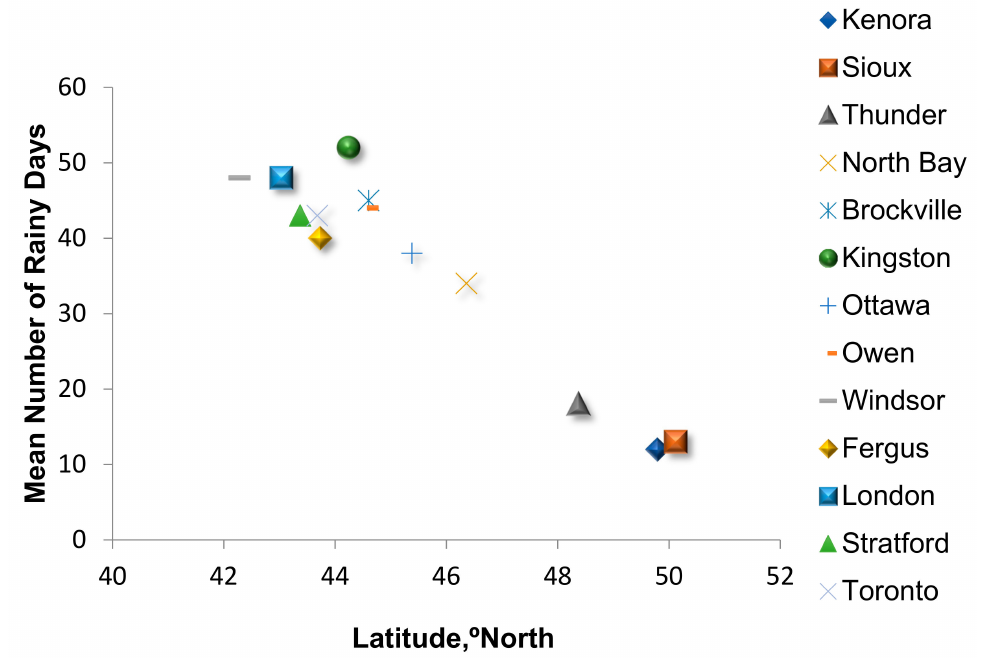
Figure 6. The variation of number of rainy days with latitude.